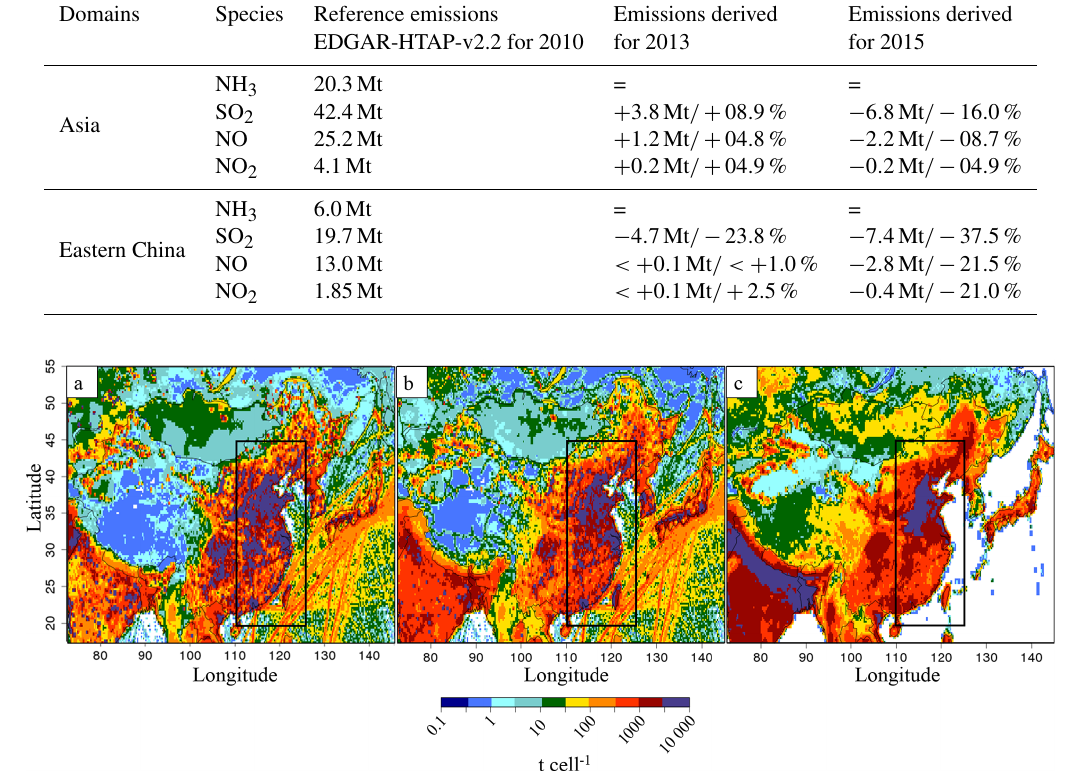
Figure 2. EDGAR-HTAP-v2.2 emissions for the year 2010 for (a) SO 2 , (b) NO and (c) NH 3 . Units are tons per cell (tcell − 1 ) (cell size of 0.25 ◦ × 0.25 ◦ ). The black rectangle shows the eastern China